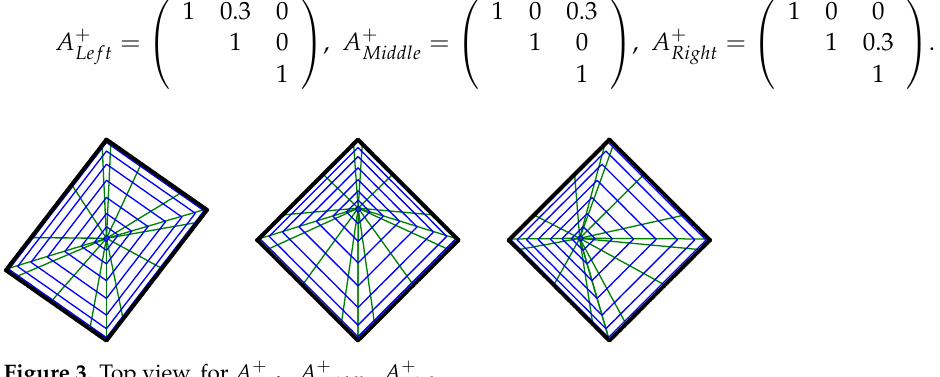
Figure 3. Top view, for A +